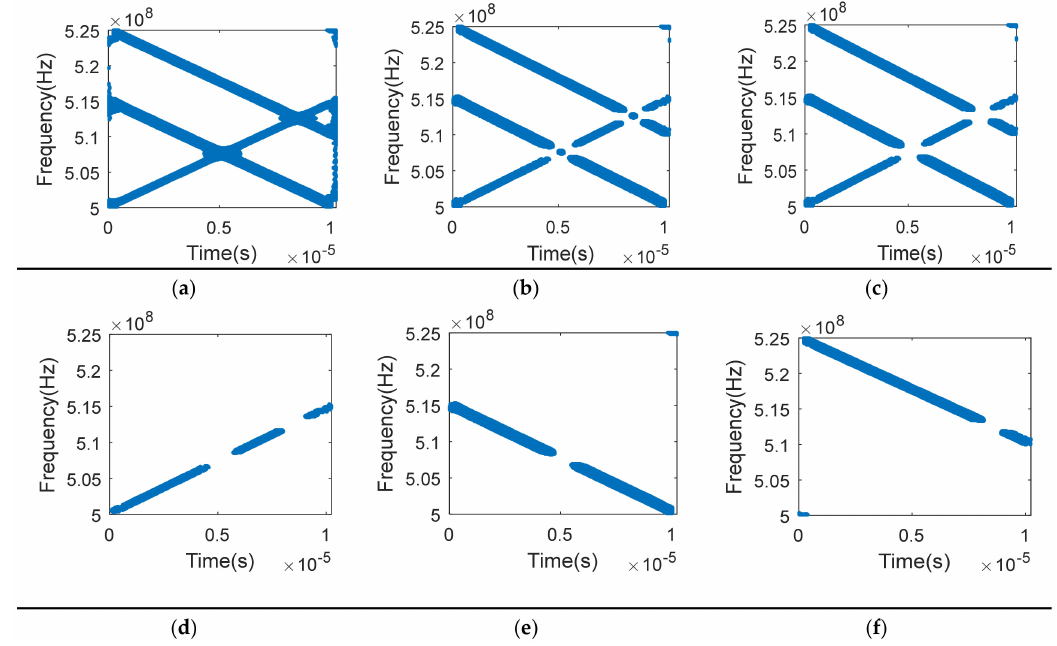
Figure 3. Processing steps of TFDs. ( a )The TFDs after removing noise points; ( b ) The TFDs of self-term points; ( c ) The TFDs of single-source self-term points; ( d )The TFDs of signal 1 after clustering; ( e ) The TFDs of signal 2 after clustering; ( f ) The TFDs of signal 3 after